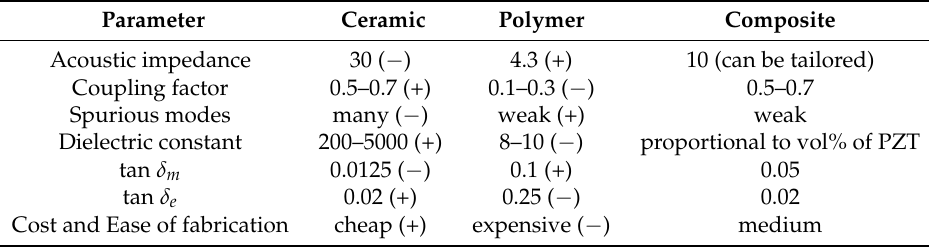
Table 1. Important material parameters for piezoelectric ceramic, polymer, and composites. Positive and negative signs next to the properties of ceramic and polymer show the advantages and limitation, respectively of that particular